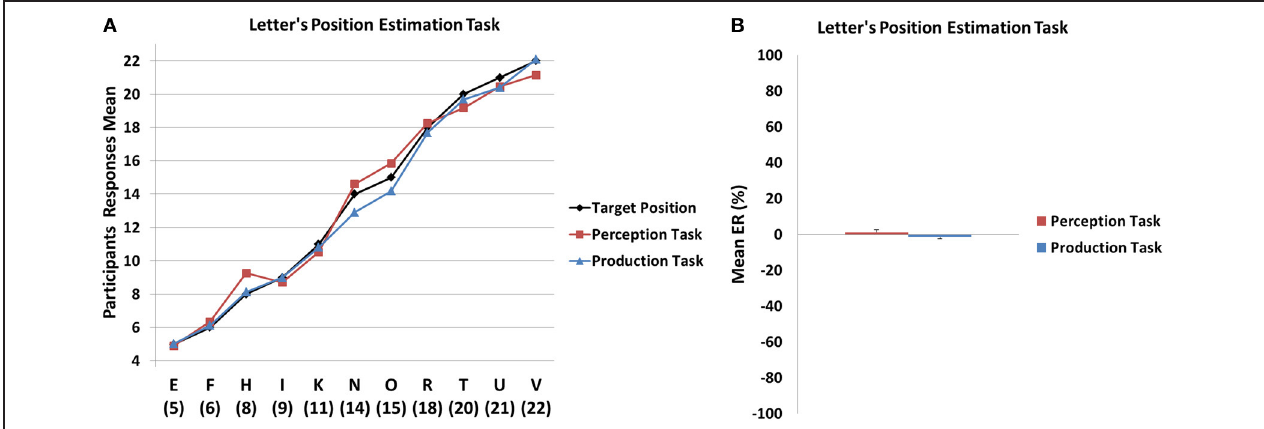
FIGURE 4 | (A) Mean estimation values observed in the Letter position perception and production tasks as a function of target values. (B) Mean error rate for the Letter position estimation tasks as a function of condition